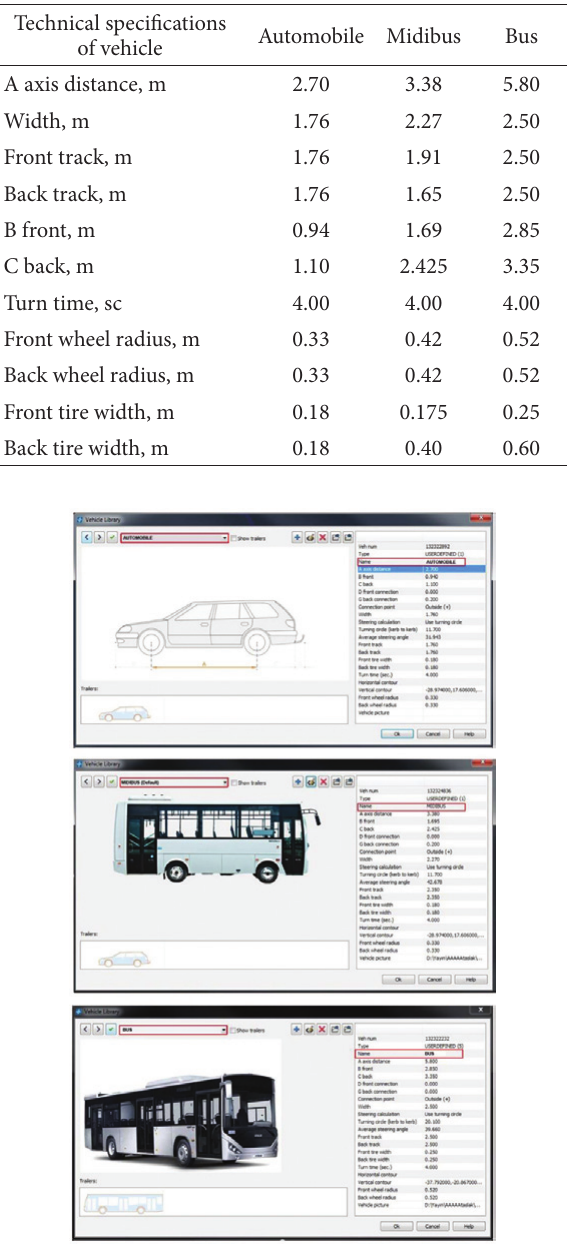
Fig. 3. Creation of a vehicle library for automobile, midibus and bus type vehicles in Plateia 2013 software